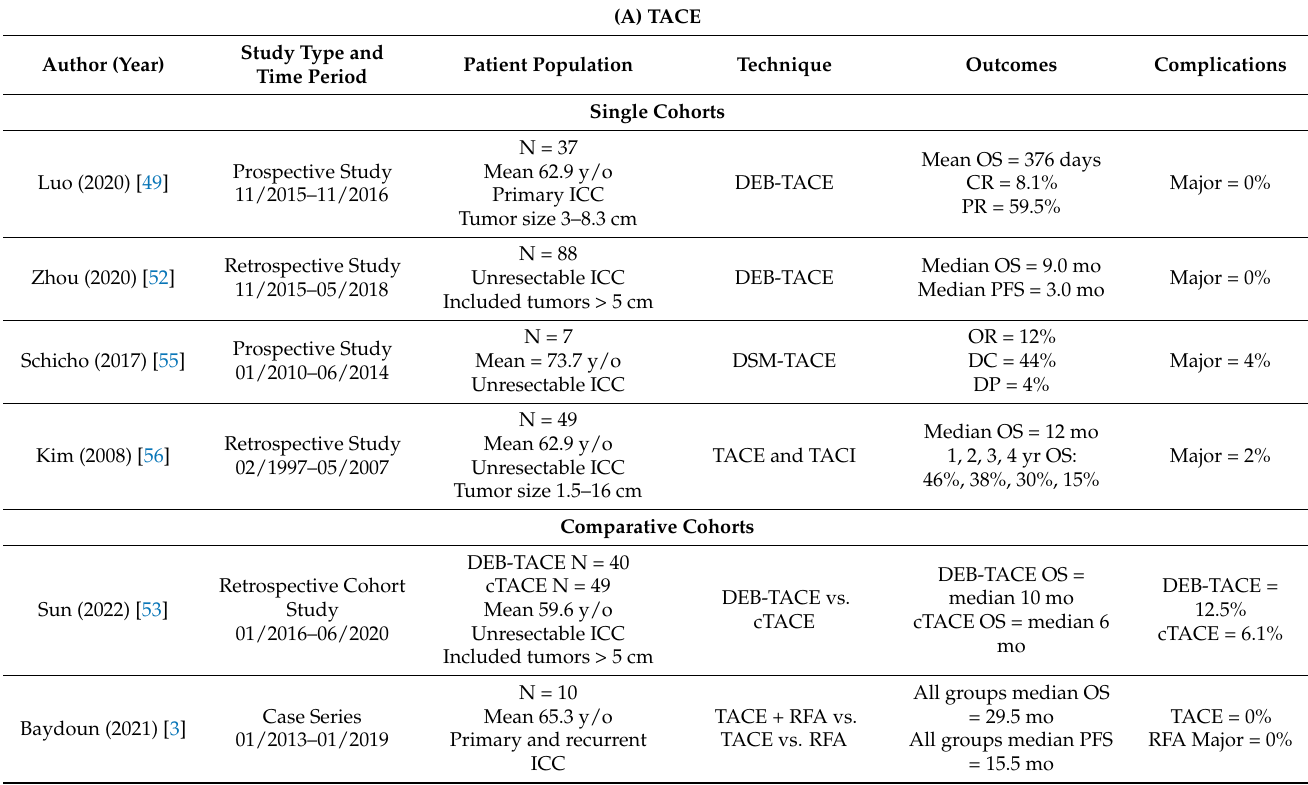
Table 3. (A) Studies examining transarterial chemoembolization (TACE) and (B) Adjuvant TACE for intrahepatic